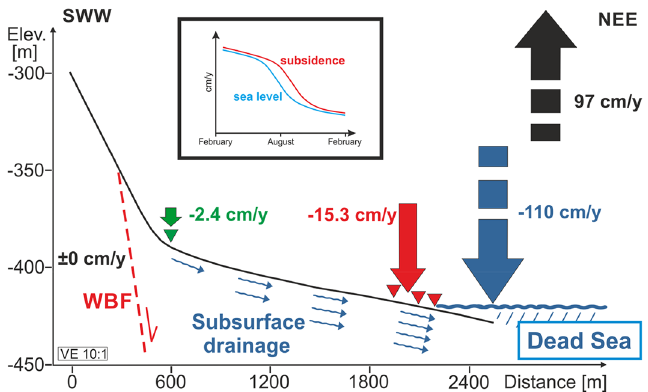
Figure 5. Sketch of the average yearly subsidence across the red profile shown in Fig. 1, from June 2014 to March 2017. The green and red triangles are the location of the GNSS stations. Green and red arrows indicate the subsidence of the surface. The area west of the WBF (Western Boundary Fault, dashed red line) shows no vertical movement (see Supplementary Figs. S_4 and S_5), whereas the subsidence increases from − 2.4 cm/year near the SPA to − 15.3 cm/year at the Beach. The main cause of the massive subsidence observed is the drainage of the sediments below the stable salt crust, due to the drop of the DS water table. Water and its movement are labeled in blue. The average drop of the DS lake level is 110 cm/year. Vertical exaggeration is 10:1. The insert is a sketch showing in a generalized way the intra-annual dynamics of DS lake level (blue) and the delayed subsidence (red) (winter to summer to